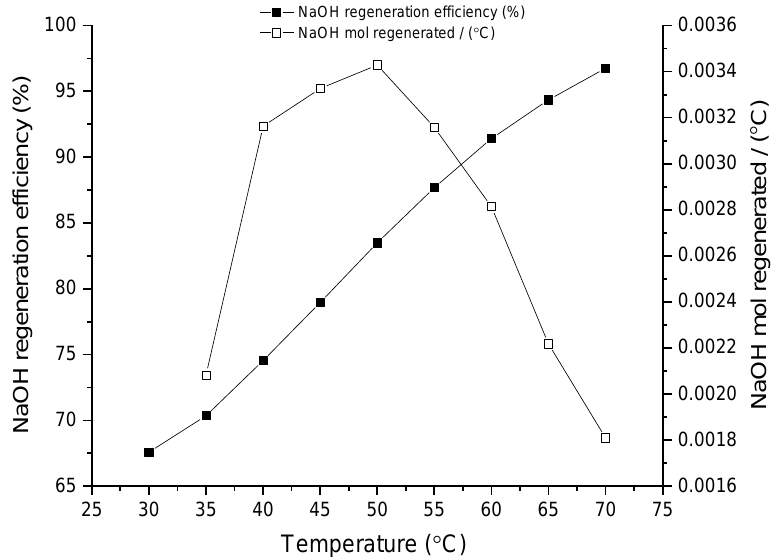
Figure 3. Influence of temperature on NaOH regeneration. Experiments carried out at R = 1.2 and t = 30 min.